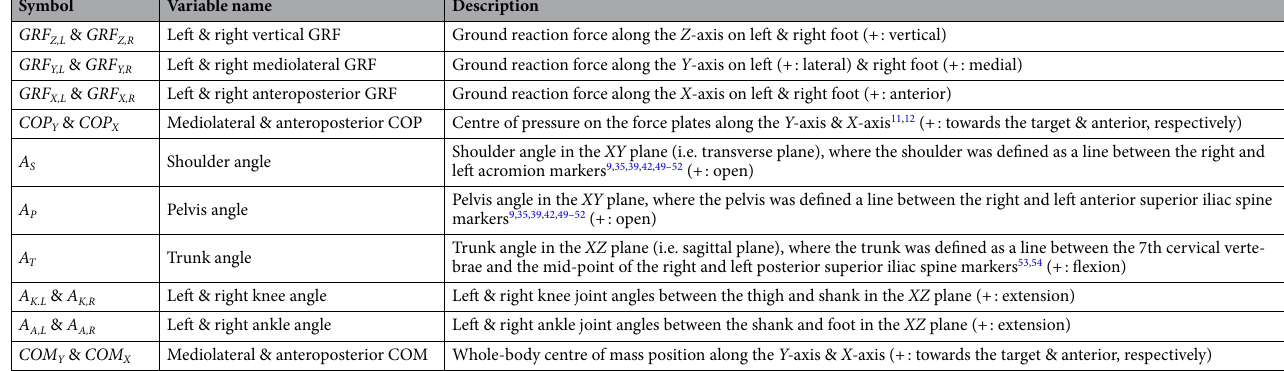
Table 1. List of kinematic and kinetic variables and